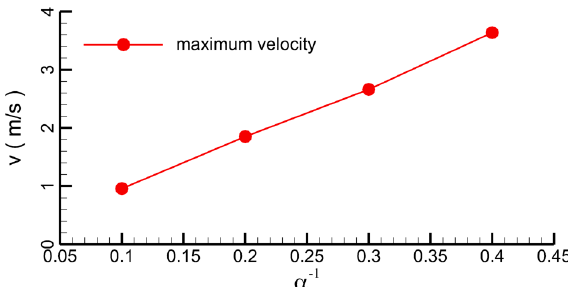
Figure 20. Time series of the tsunami-like wave profile recorded at sensor L 1 .